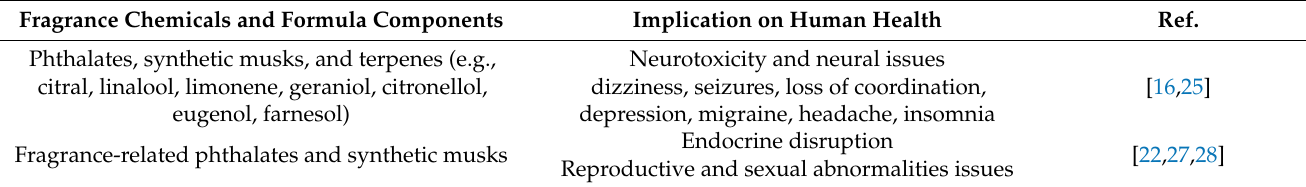
Table 1. Examples of fragrance chemicals and PHCPs’ formula components associated with adverse health